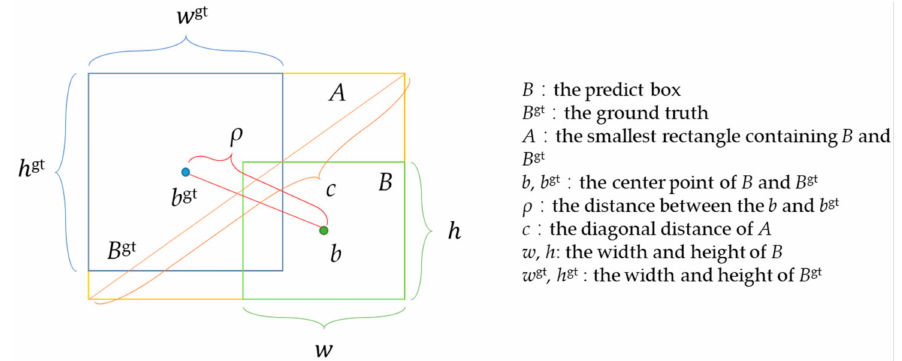
Figure 3. Description of